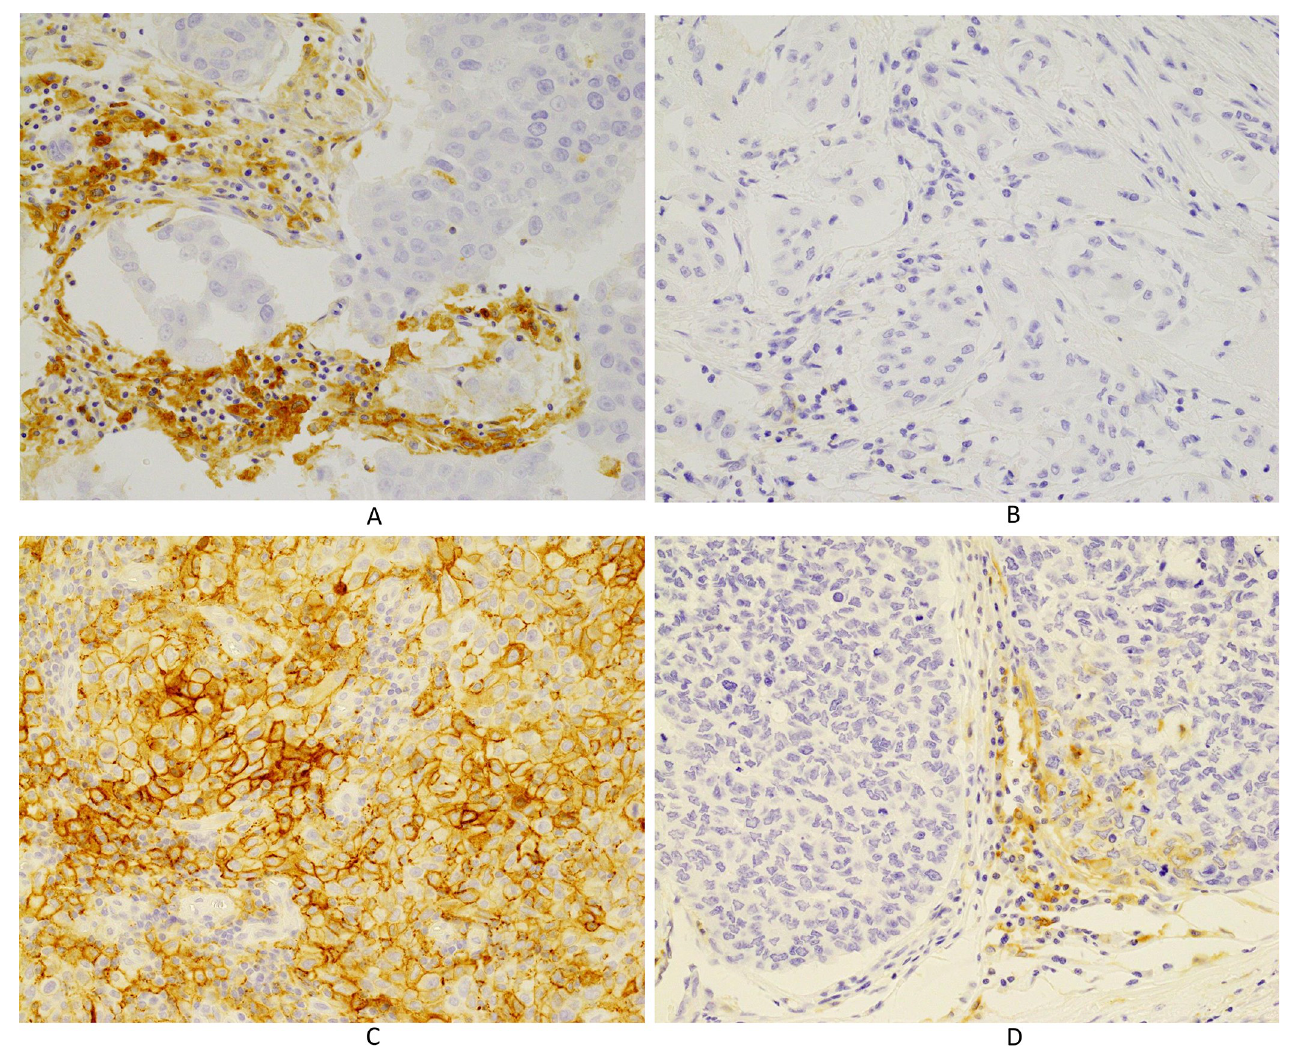
Fig 1. Immunohistochemical staining for PD-L1 using the 73–10 assay. (A) PD-L1 is expressed in immune cells ( × 400). (B) No PD-L1 expression is noted in immune cells ( × 400). (C) PD-L1 is expressed in carcinoma cells ( × 400). (D) PD-L1 is not expressed in carcinoma cells ( ×